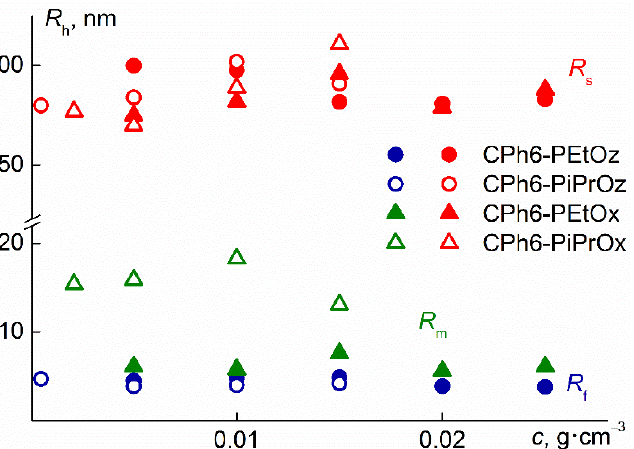
Figure 4. The dependences of the hydrodynamic radii R h of scattering species on concentration c for aqueous solutions of star-shaped CPh6-PEtOz and CPh6-PEtOx 15 °C and CPh6-PiPrOz and CPh6-PiPrOx at 21 °C.